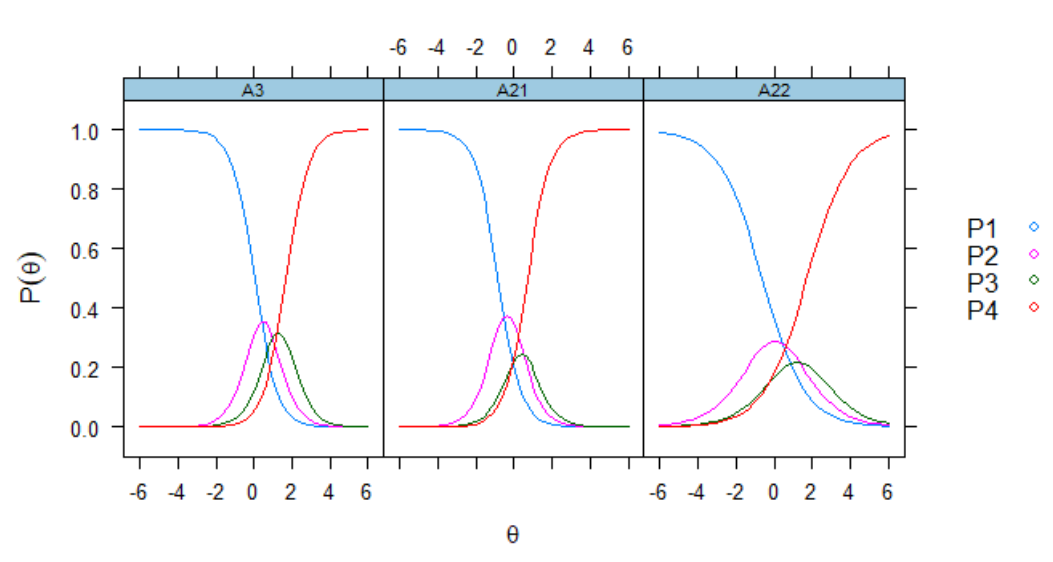
Figure 8. ICCs of the Social Recognition Needs component.